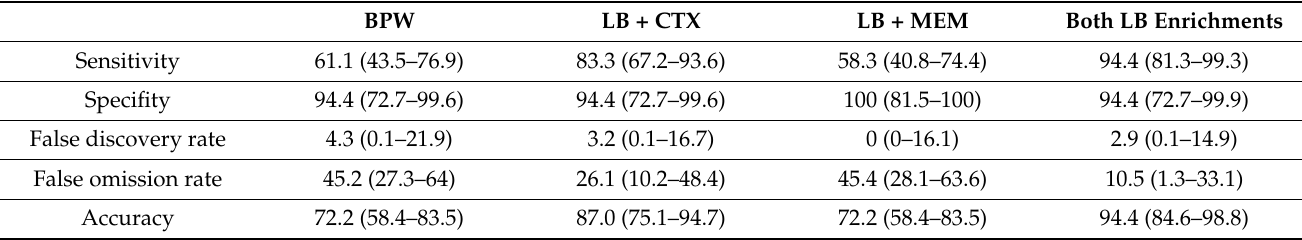
Table 3. Accumulated results on the weekly detection of carbapenemase genes from the spiked fecal samples. BPW was used for the first enrichment, LB + CTX and LB + MEM were used parallel as second enrichments. Corresponding exact 95% confidence intervals are provided in